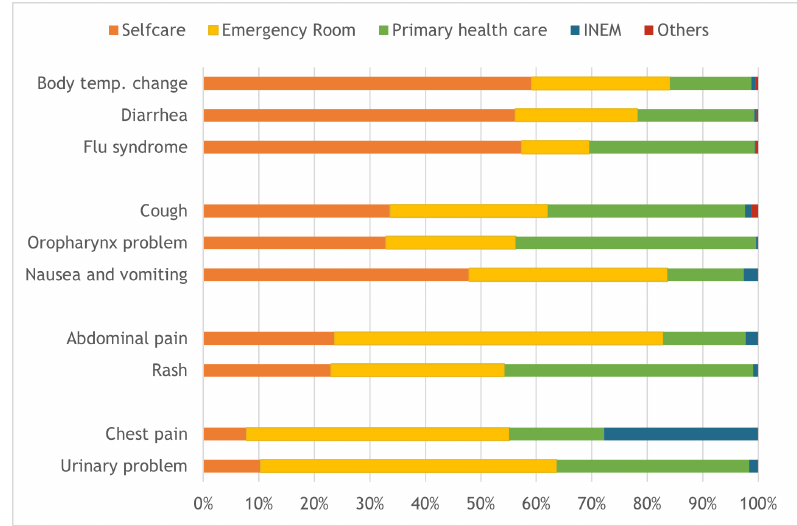
Figure 9. Distribution of referrals for the 10 most common pathways.